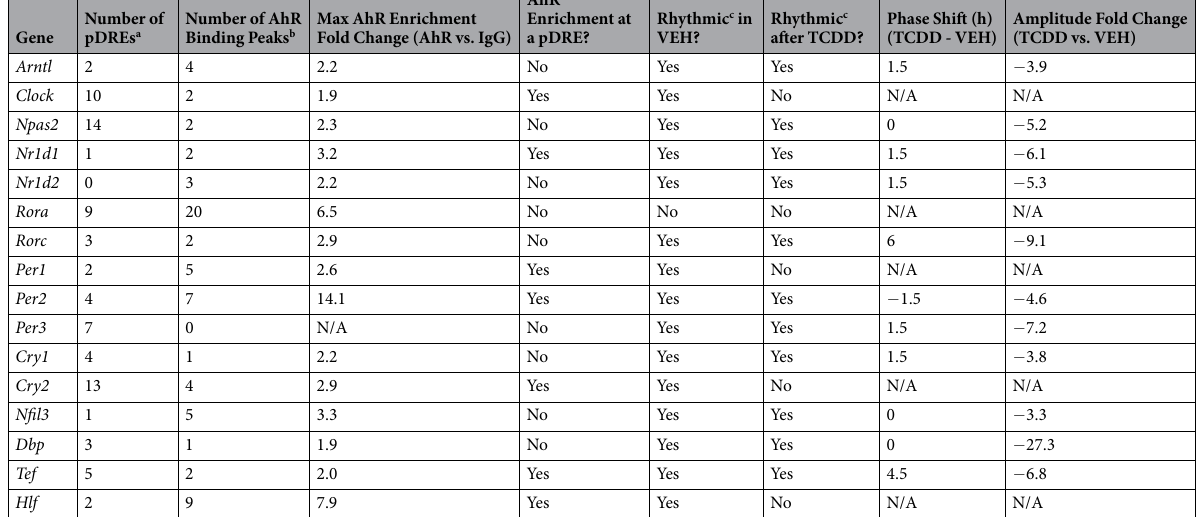
Table 1. Putative dioxin response elements (pDREs) and AhR binding within core clock genes. a Putative dioxin response elements (pDREs; MSS ≥ 0.856) were identified by computationally querying the mouse genome 46 . b AhR genomic enrichment was determined through ChIP-Seq analysis of male livers 2 h after treatment